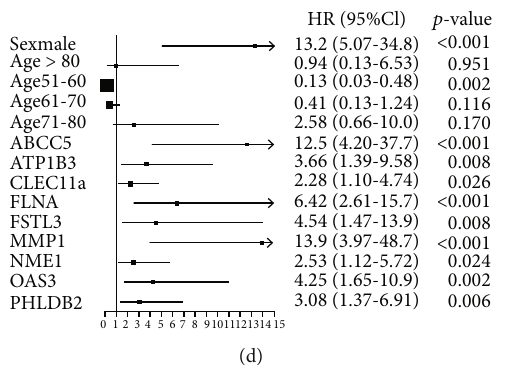
Figure 4: SMPs in the LASSO regression model to predict the survival of LSCC: (a) coe ffi cient pro fi les of variables in the LASSO regression model; (b) tenfold cross-validation for selecting parameter λ in the LASSO regression model; (c) survival curves of the selected SMPs; (d) forest plot of the Cox multivariate analysis.